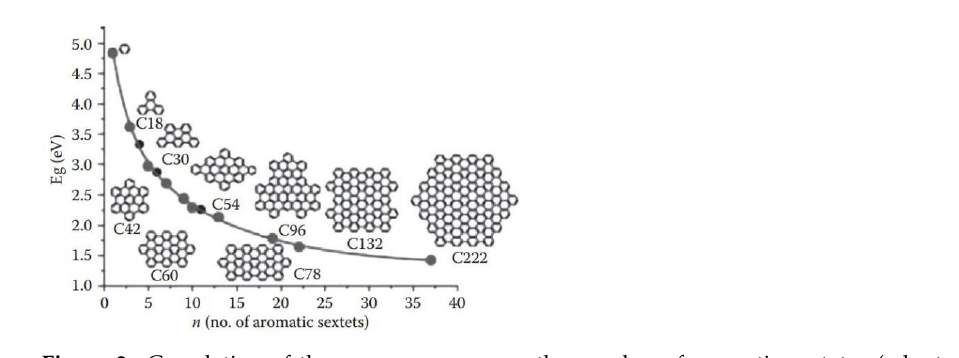
Figure 3. Correlation of the energy gap versus the number of aromatic sextets. (adapted from ref. [66]).